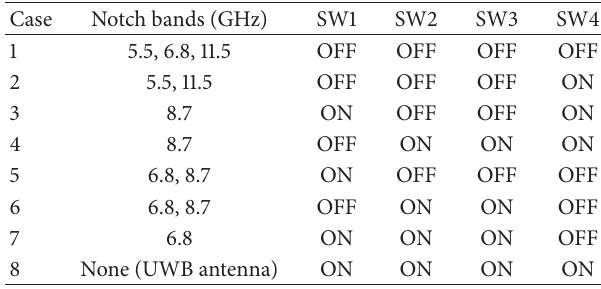
Table 1: Eight switchable cases and corresponding notch